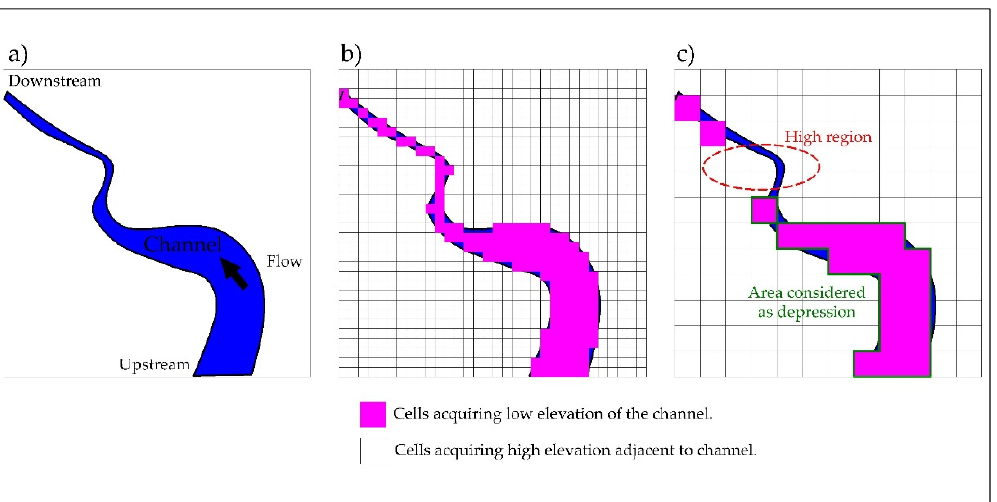
Figure 13. Y-Y’ axis topographic profiles from merged DEM.